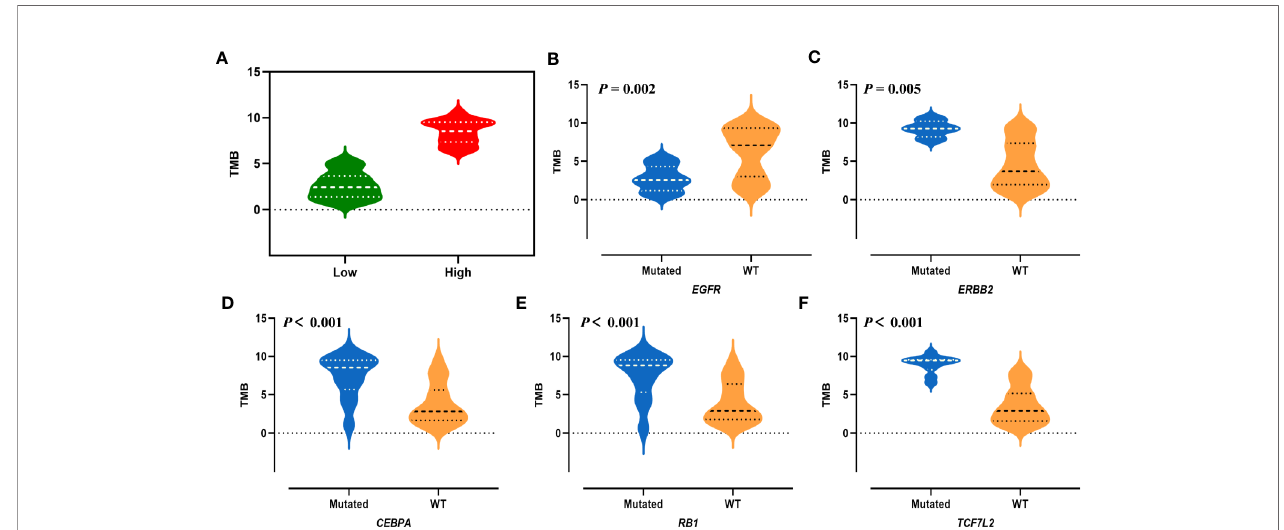
FIGURE 6 | Tumor mutation burden of LUAD. (A) The distribution of TMB across all patients, using a threshold of 6.3 mutations/Mb. Low (<6.3 mutations/Mb), and high ( ≥ 6.3 mutations/Mb). Comparison of TMB according to EGFR mutations (B) , ERBB2 mutations (C) , CEBPA mutations (D) , RB1 mutations (E) , TCF7L2 mutations (F)